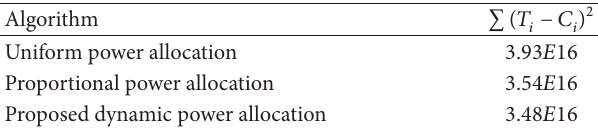
Table 2: System’s total squared difference for the three algorithms from Scenario